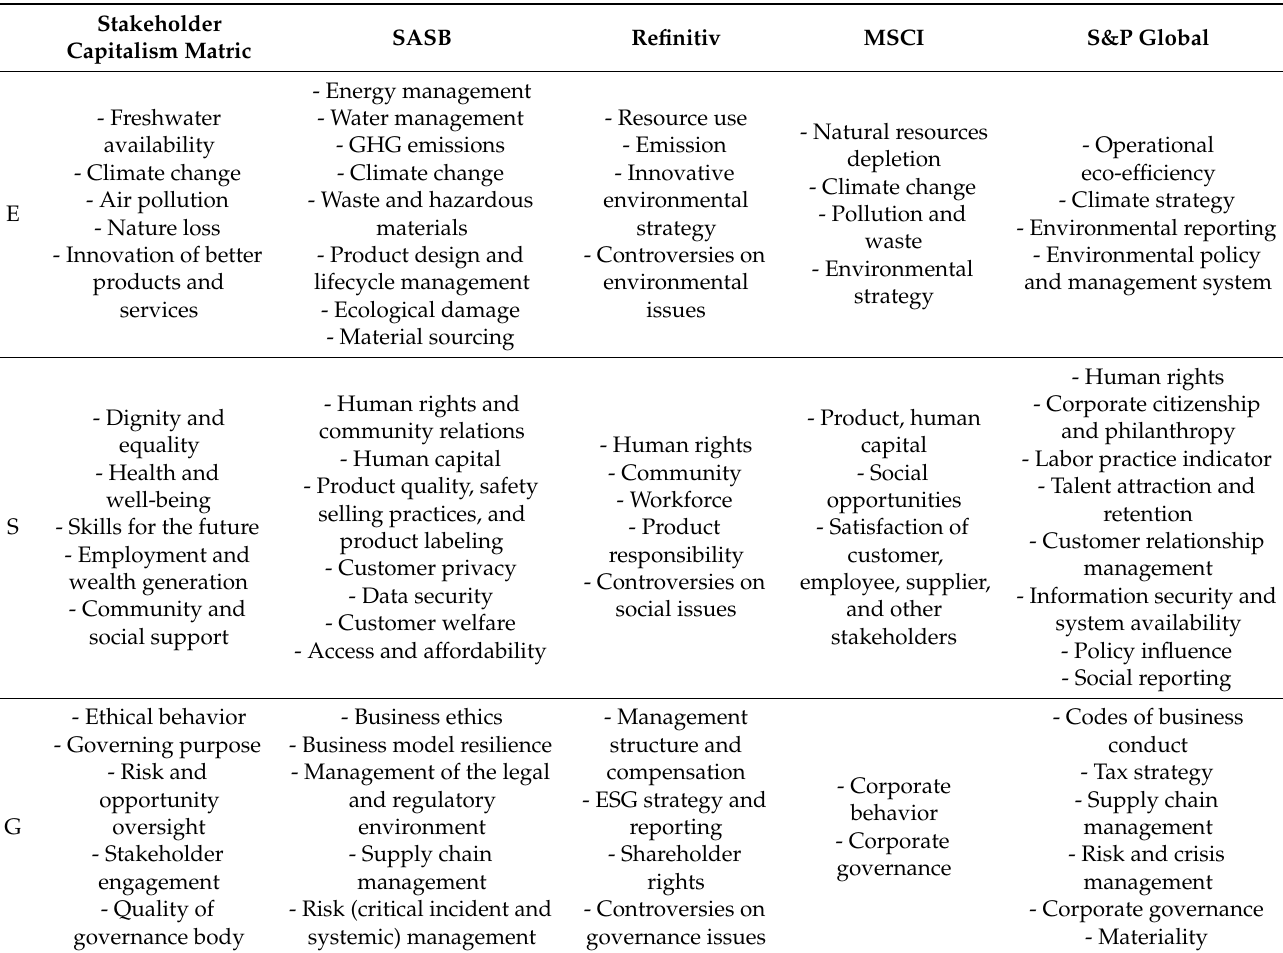
Table 1. ESG components of the five information